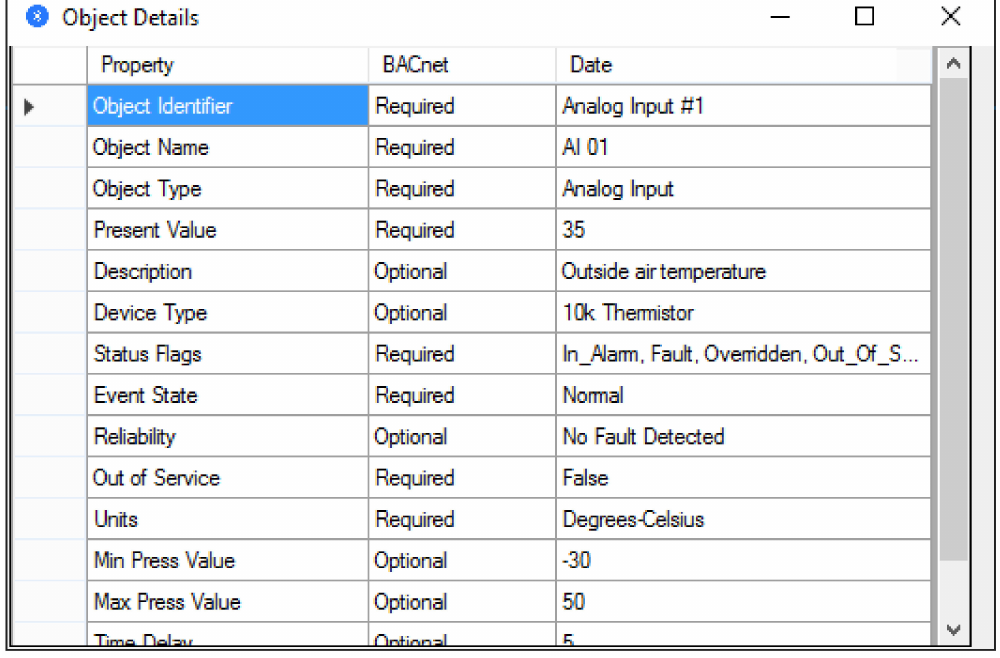
Figure 7. Details related to a BACnet